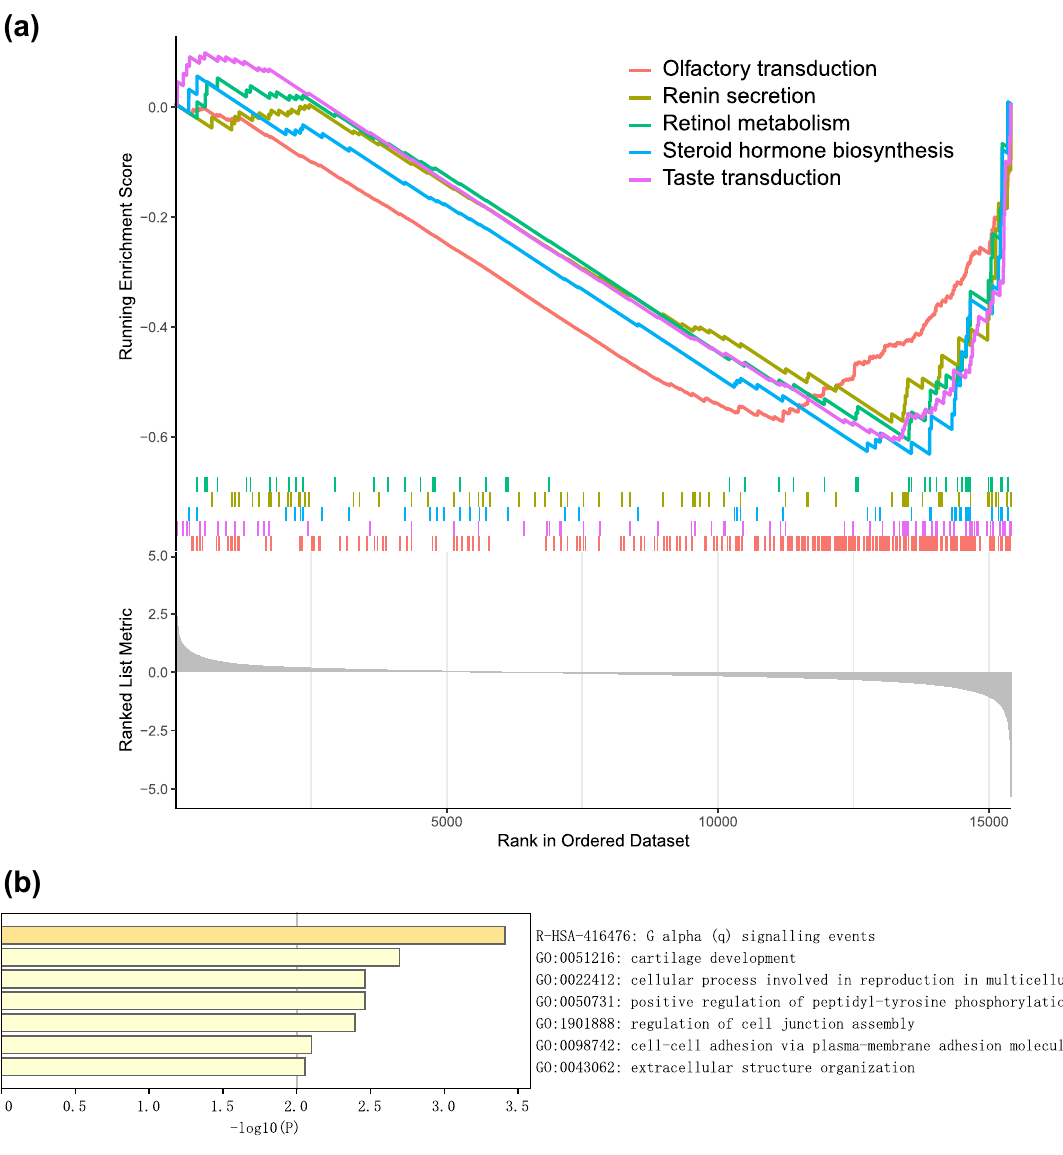
Figure A1: Heatmap of pathway enrichment